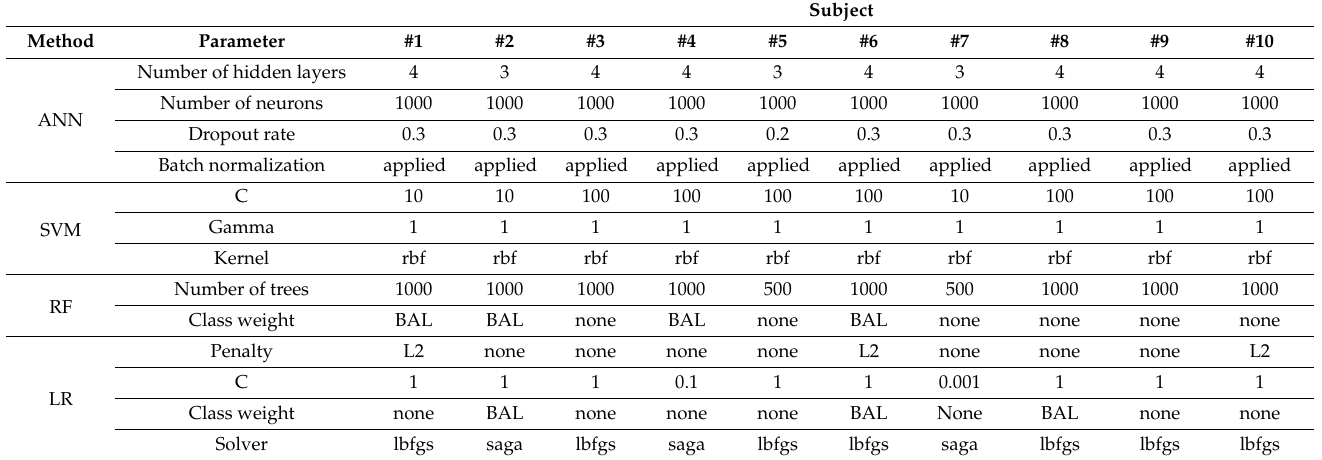
Table 2. Best parameters selected by a grid search process for each subject and machine learning method.